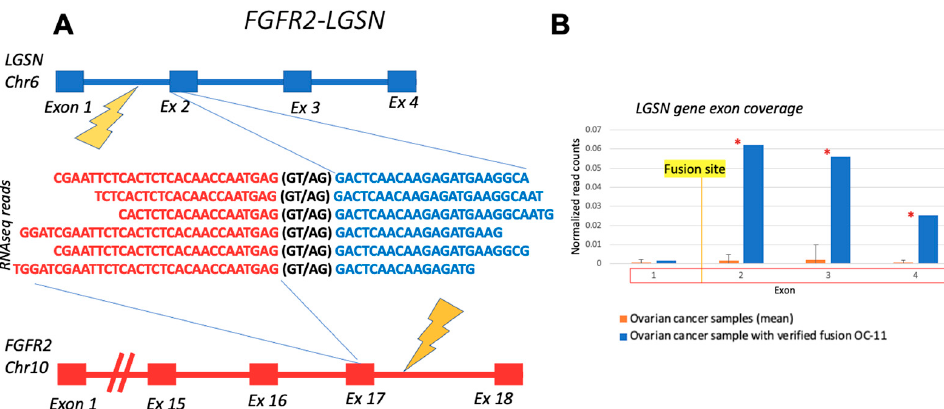
Figure 7. Schematic representation and RNAseq reads coverage of FGFR2-LGSN fusion transcript identified in OC11 sample: ( A ) fusion partner gene structures upstream and downstream of fusion site; ( B ) LGSN exon coverage by normalized RNA sequencing reads in OC-11 sample (blue) and in control ovarian cancer samples without fusion (orange). Double normalized exon coverage by RNA sequencing reads is shown: (i) by exon length and (ii) by overall gene expression level in a sample. *—the coverage of exon in OC-11 sample is higher than the 95th percentile of exon coverage in unrelated control ovarian cancer samples without fusion.